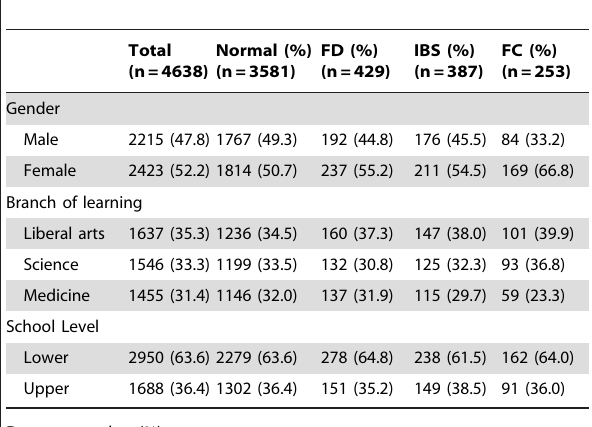
Table 1. Characteristics of students with functional gastrointestinal